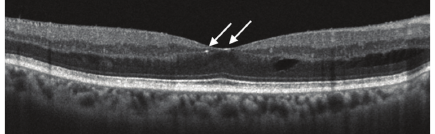
Figure 2: SD-OCT of the right eye demonstrated highly reflective intraretinal crystals in the inner foveal layers (arrows) and outer intraretinal fluid. Other studies have also localized the crystals to Henle’s layer